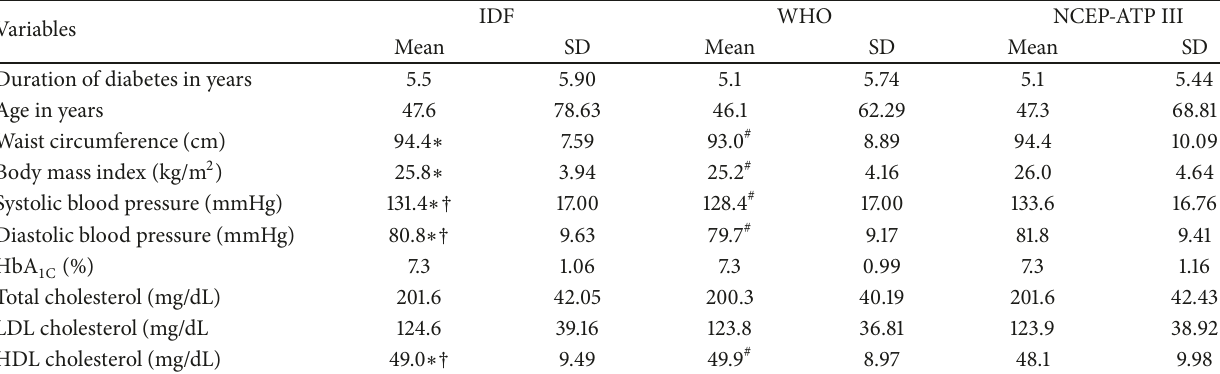
Table 5: General characteristics of the subjects with metabolic syndrome according to the three definitions.